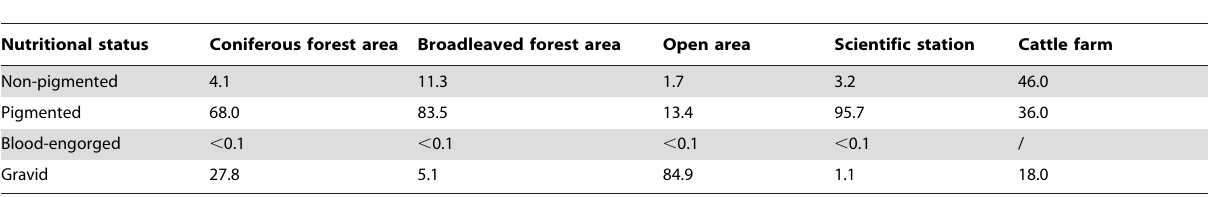
Table 2. Nutritional status (percentage) of female Culicoides trapped at the five study sites.